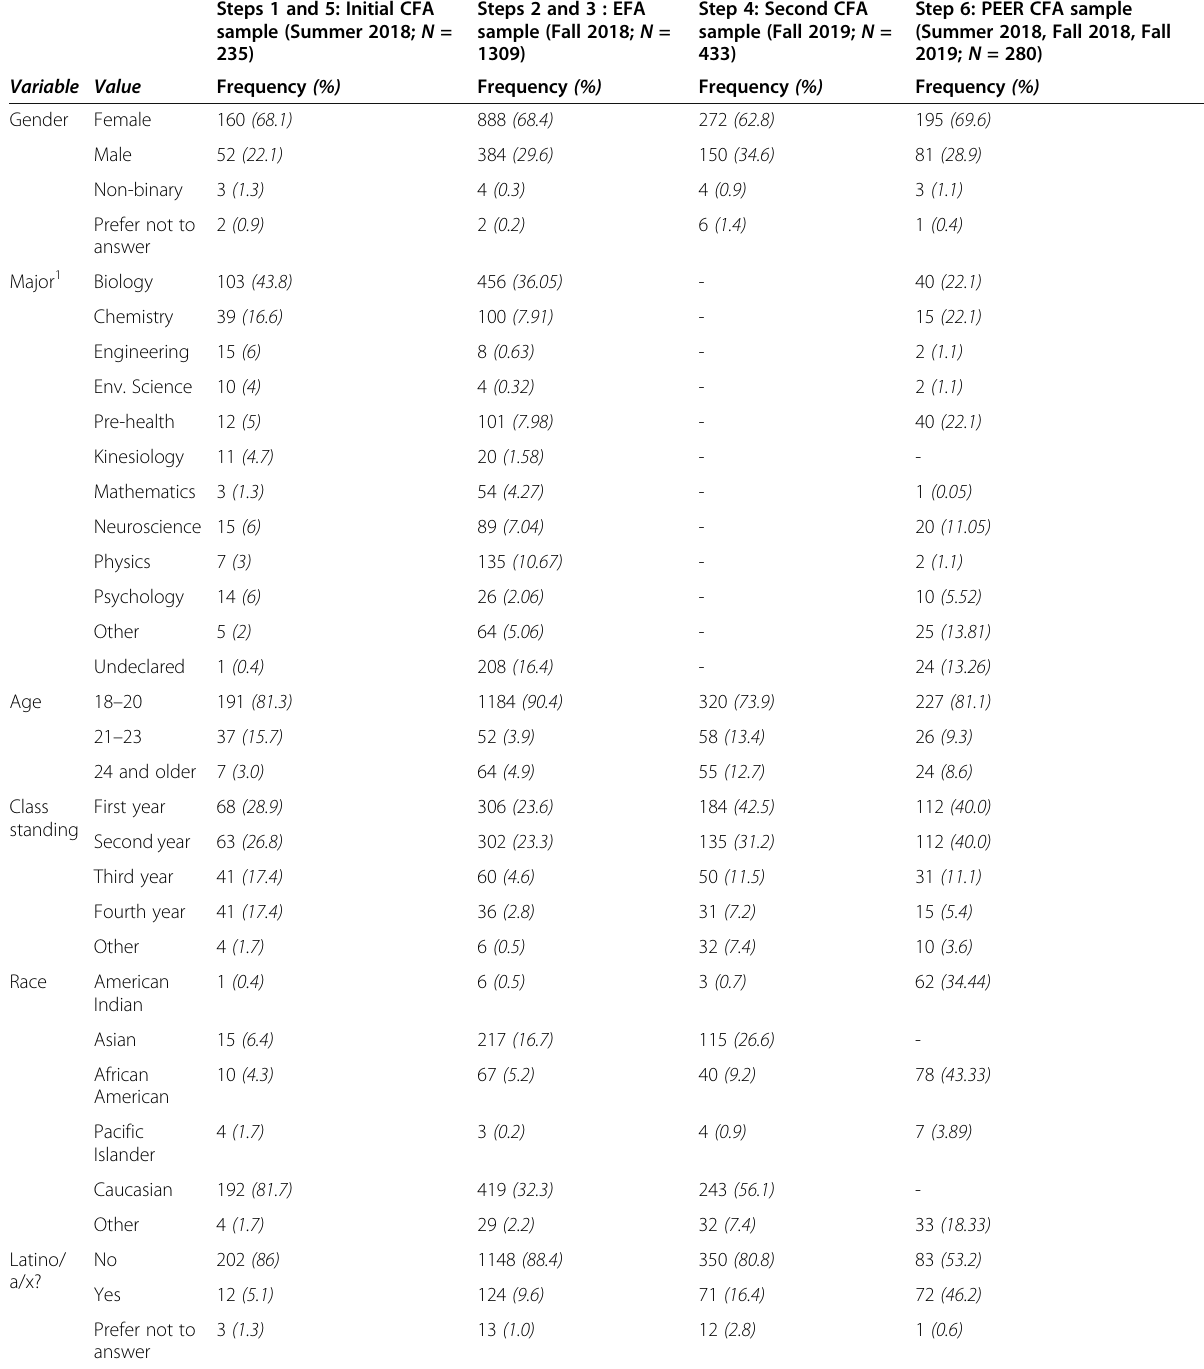
Table 3 Demographic characteristics of